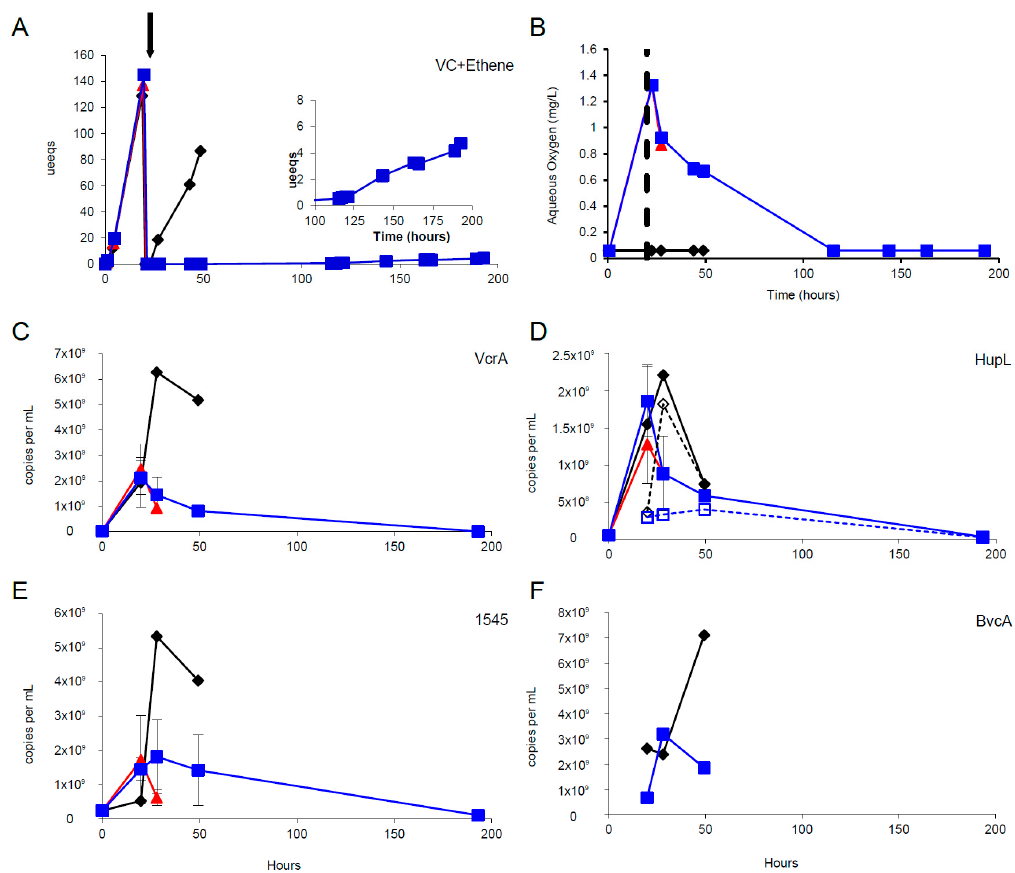
Figure 4. Timecourses of metabolite ( A ), oxygen ( B ), and mRNA ( C – F ) concentrations for specific targets in oxygen stress experiments. The arrow in A (vertical dashed line in B) indicates when the stress was added at 20 h. The controls are in black diamonds, and the stressed bottles are in red triangles (sacrificed ~12 h after stress) and blue squares (sacrificed at end of the experiment). Note that VC + ethene production is recovering at ~100 h after the oxygen stress (inset in panel A). Error bars represent standard error of duplicate reactors. For hupL in panel D, results from degenerate primer sets (dashed lines) are plotted on the same set of axes. Full dechlorination profiles are shown in Figure S3.